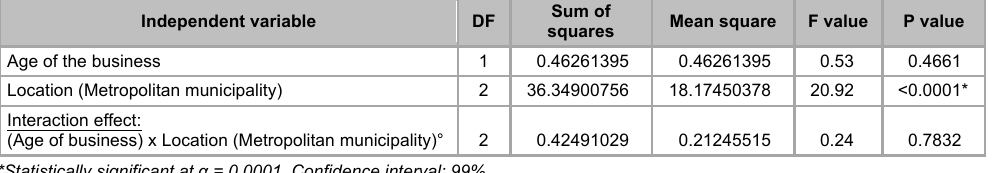
Tests of Between-Subjects effects for the factor “Objectives of the small business policy” as dependent variable Sum of Independent variable DF squares Mean square F value P value Age of the business 1